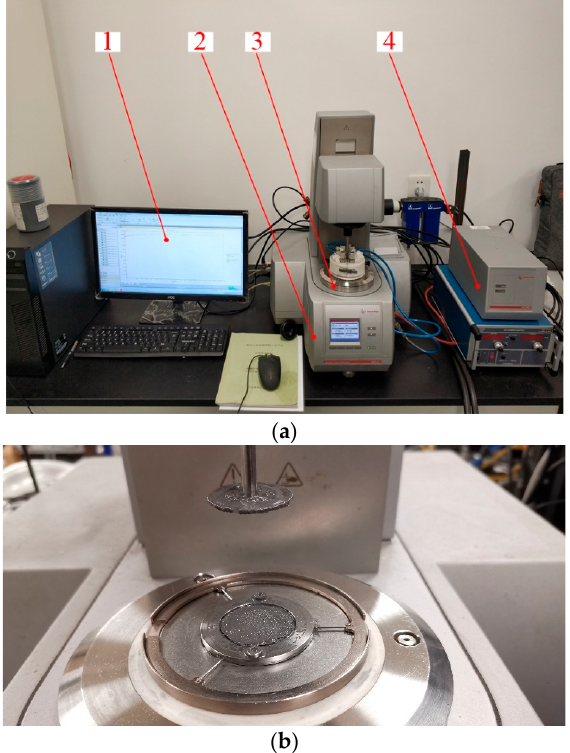
Figure 3. Experimental set-ups of the MR porous fabric composite. ( a ) Experimental system: (1) control platform, (2) rheometer, (3) test platform, (4) magnetic field control unit. ( b ) main body of test.